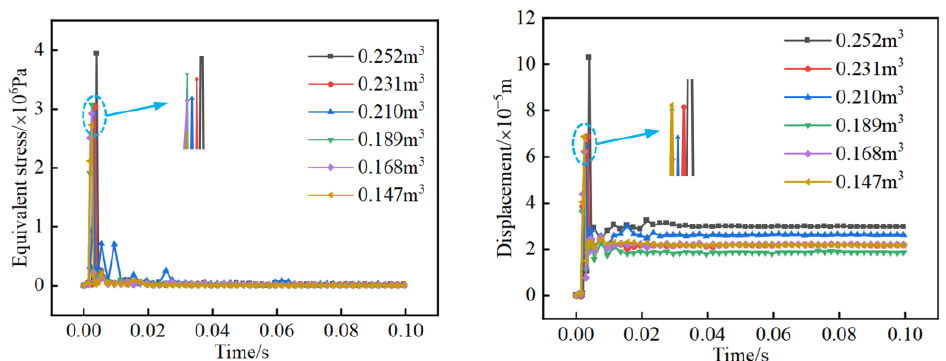
Figure 13. Time – history curves of equivalent stresses ( left ) and X -displacements ( right ) for different drift ice sizes.